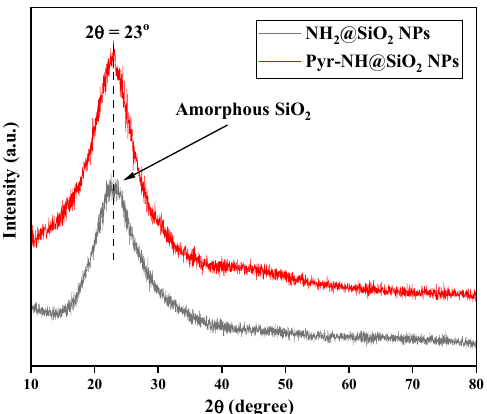
Figure 1. XRD patterns of ( – ) NH 2 @SiO 2 NPs and ( – ) Pyr-NH@SiO 2 NPs. The surface morphology and particle size of as-synthesized silica and pyrene at- tached silica NPs were examined via field emission scanning electron microscopy (FESEM). Figure 2 (high-resolution) and Figure S5 (low-resolution) represent FESEM images of (a) NH 2 @SiO 2 NPs and (b) Pyr-NH@SiO 2 NPs, respectively. It seems that the spher- ical-shaped silica particles are well-dispersed, homogeneous in size, and uniformly dis- tributed over the surface. The average size of NH 2 @SiO 2 NPs and Pyr-NH@SiO 2 NPs are ~35 and ~40 nm, respectively. The comparison indicates that the Pyr-NH@SiO 2 NPs are more compact compared to NH 2 @SiO 2 NPs, which may be due to aggregation occurring by π – π interactions between the organic moieties. Moreover, there is no significant change in the average size of silica NPs upon attachment with pyrene components. The elemental composition was evaluated via energy-dispersive X-ray spectroscopy (EDS) for the se- lected area of micrograph. The elemental mapping of Pyr-NH@SiO 2 NPs signifies the pres- ence of Si, O, C, and N atoms in the investigated sample (Figure S6, ESI). The elemental maps exhibit a homogenous distribution of all components.